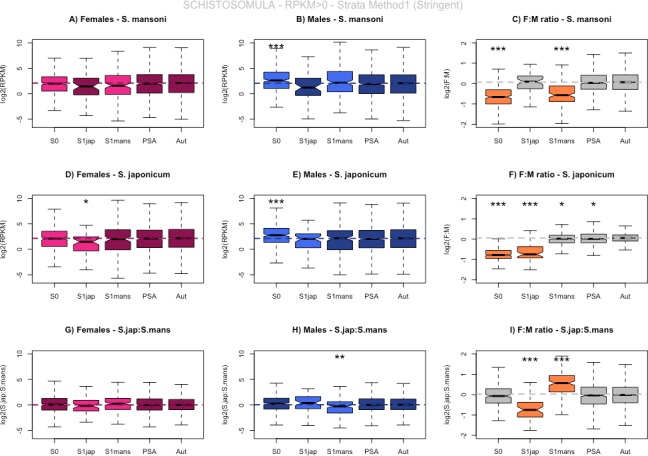
Schistosomula expression patterns (RPKM>0, stringent strata) of genes located in the different strata of the Z (S0, S1man and S1jap), as well as pseudoautosomal and autosomal genes.The distribution of expression values is shown for (A) S. mansoni females, (B) S. mansoni males, (C) S. mansoni female:male, (D) S. japonicum females, (E) S. japonicum males, (F) S. japonicum female:male, (G) Female expression in S. japonicum divided by female expression in S. mansoni, (H) Male expression in S. japonicum divided by male expression in S. mansoni, (I) female:male ratio of expression in S. japonicum divided by female:male ratio of expression in S. mansoni. Asterisks represent levels of significance of comparisons to the control autosomal genes (*p-value<0.05, **p-value<0.001, ***p-value<0.0001). Genes previously mapped to the ZW linkage group were assigned to each Z-chromosome stratum based on their coverage patterns (stringent classification); only genes with RPKM >0 were used.